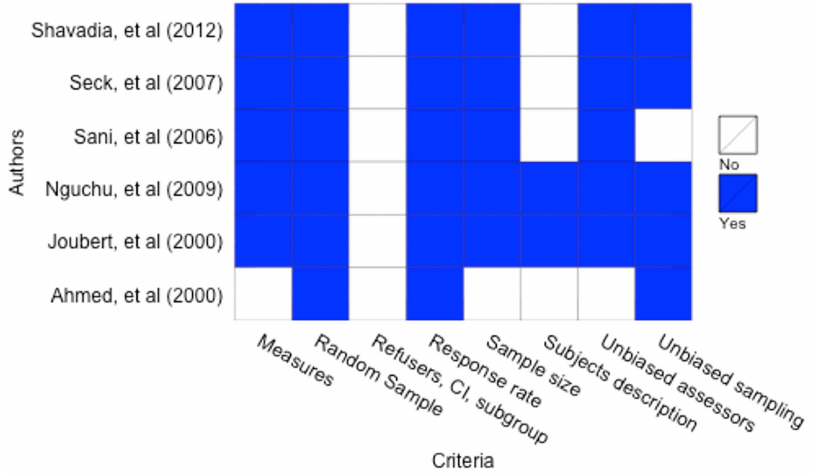
Figure 2. Methodological quality assessment of included studies.*Blue cells indicate a score of ‘‘1’’ (present) and white cells indicate a score of ‘‘0’’ (absent).